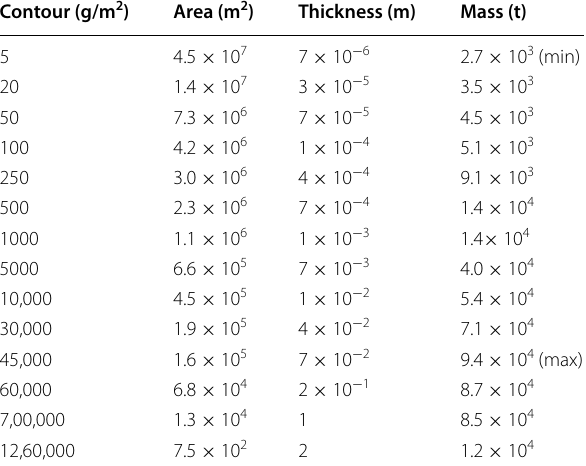
Table 1 Areas enclosed by each isomass contour. The right column is the total discharged mass estimated using the Hayakawa (1985) method for each contour line Contour (g/m 2 )